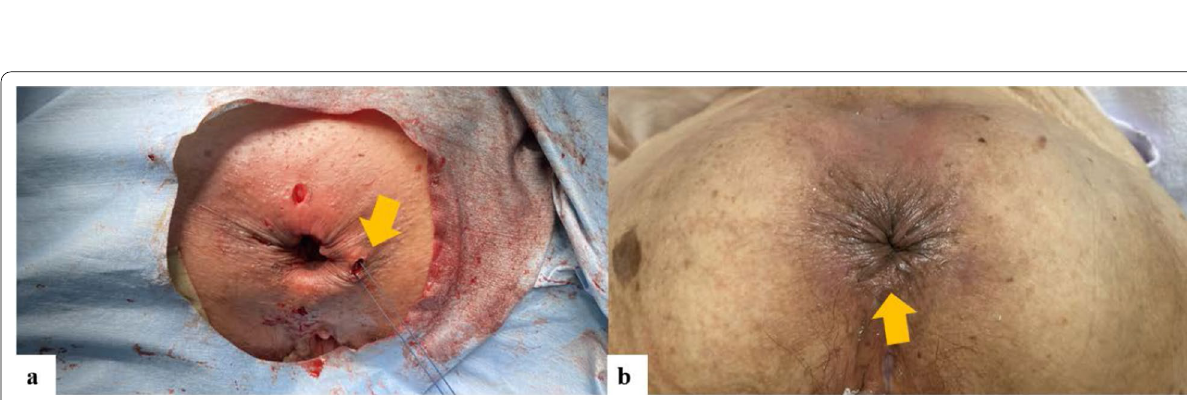
Fig. 2 a The Thiersch operation was additionally performed with 1-0 nylon thread 1 cm away from the anal verge after perineal stapled prolapse resection. b Anal findings 2 months after